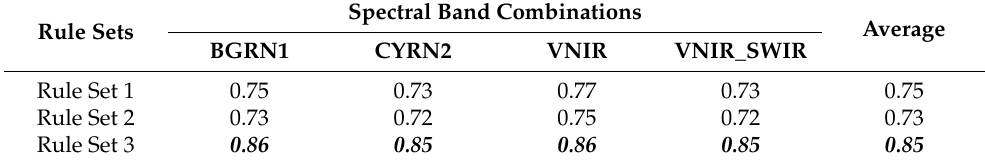
Table 9. Performance of GEOBIA in the current study averaged across all processing schemes for each subset using the F1 score. The values of the best performing classifiers are highlighted in bold and